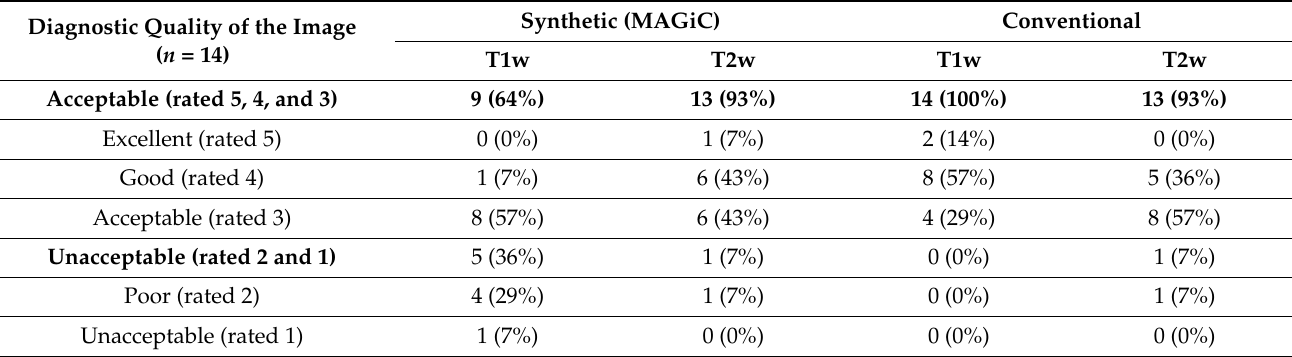
Table 3. Diagnostic image quality rating of synthetic and conventional T1w and T2w images.